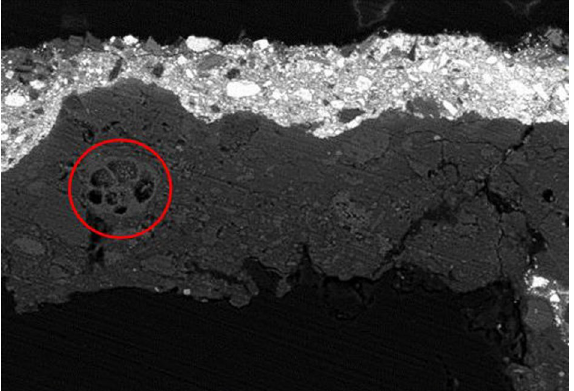
Figure 6. Scanning electron microscope photography in backscattered electron mode. A fossilized shell of calcium carbonate can be observed (red